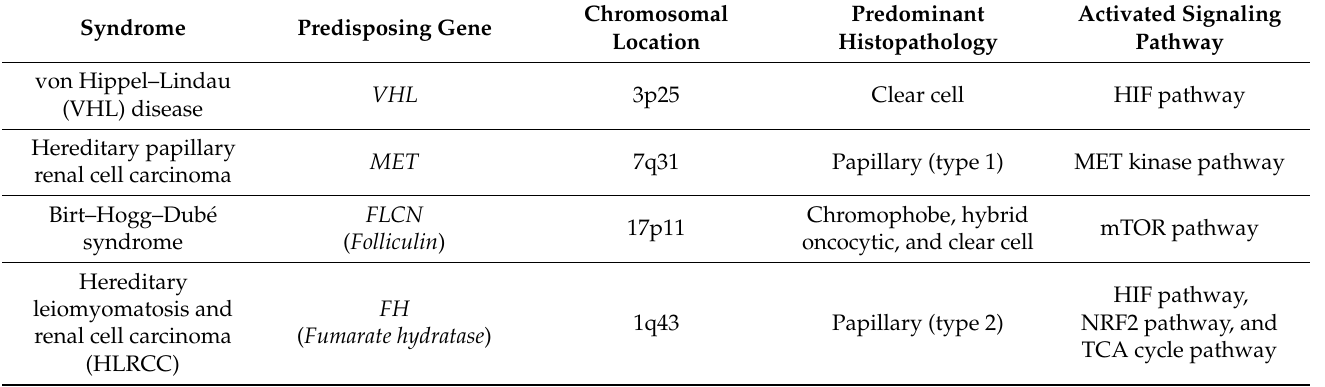
Table 1. Inherited renal cancer syndromes with predisposing genes: the chromosomal location, predominant histopathology, and activated signaling